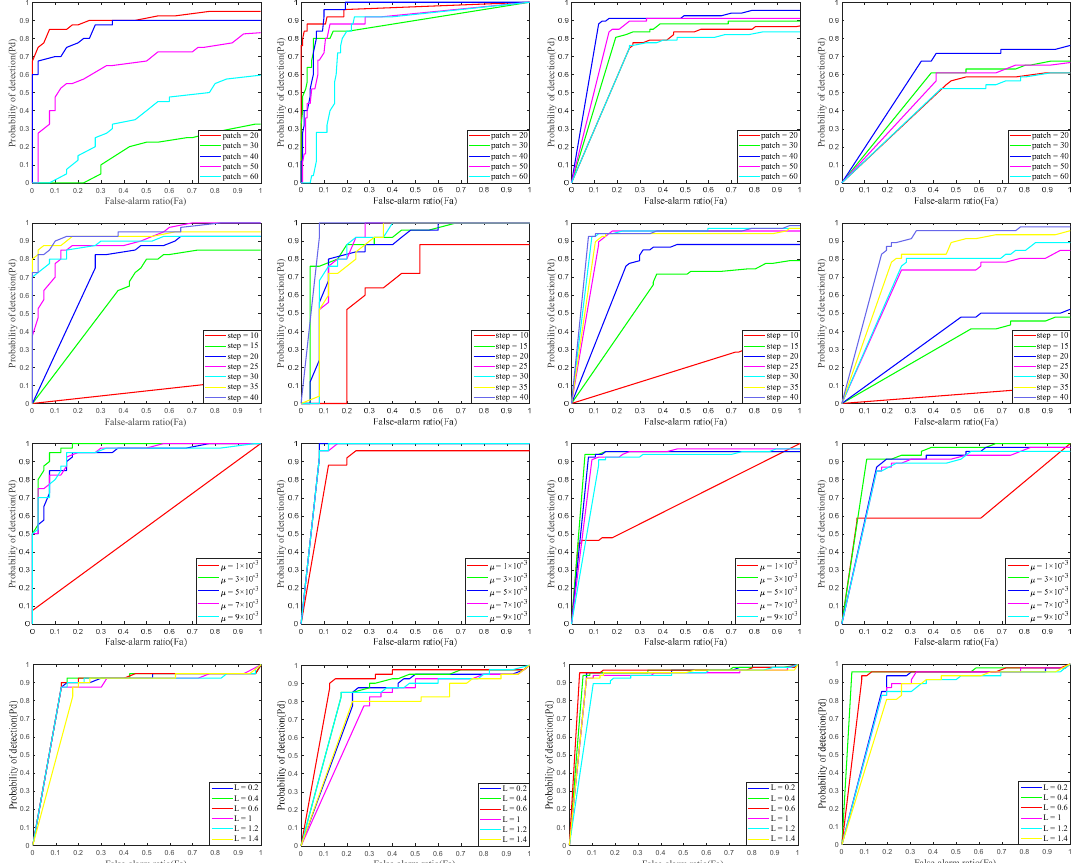
Figure 10. Detection performances under different parameters. Rows 1: ROC curves with respect to different patch sizes, Rows 2: ROC curves with respect to different sliding steps, Rows 3: ROC curves with respect to different penalty factors, Rows 4: ROC curves with respect to different compromising